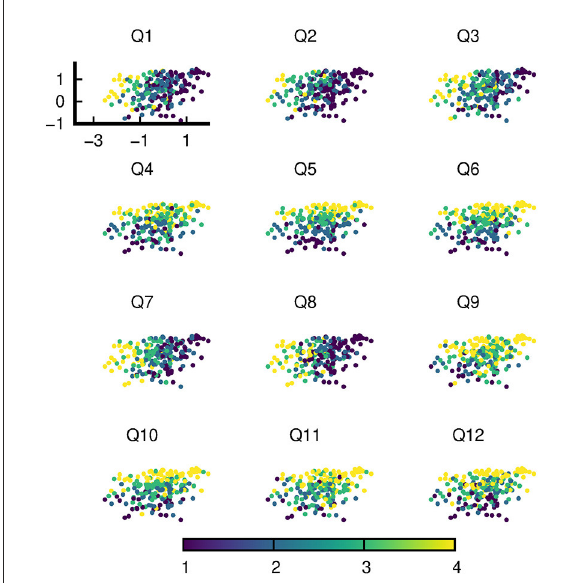
FIGURE1 An instance of latent variables of a random subset of data on the trained VAE. The VAE was trained with this very subset of data. Each of the 12 sub-figures is color coded with the responses of one of 12 questions (Q1-Q12).